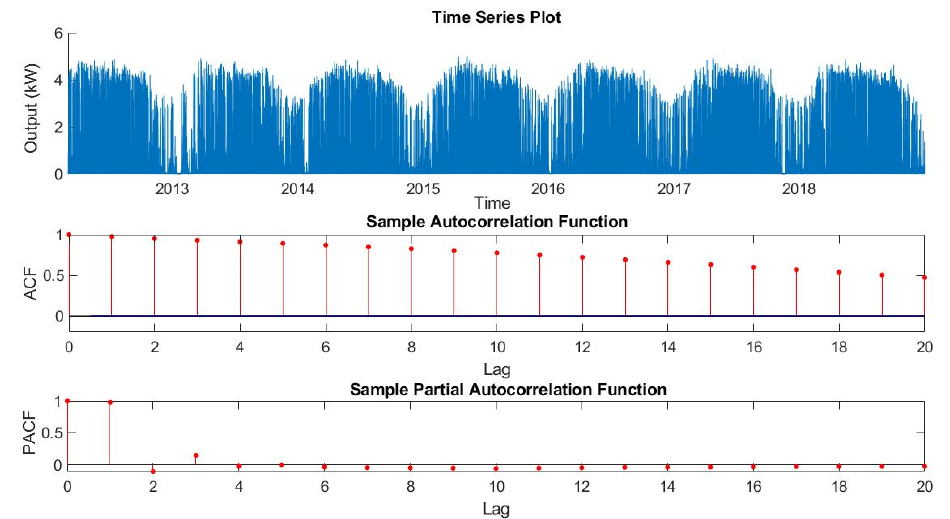
Figure 4. Solar panel output data with an auto correlation function (ACF) and a partial auto correlation function (PACF) analysis.